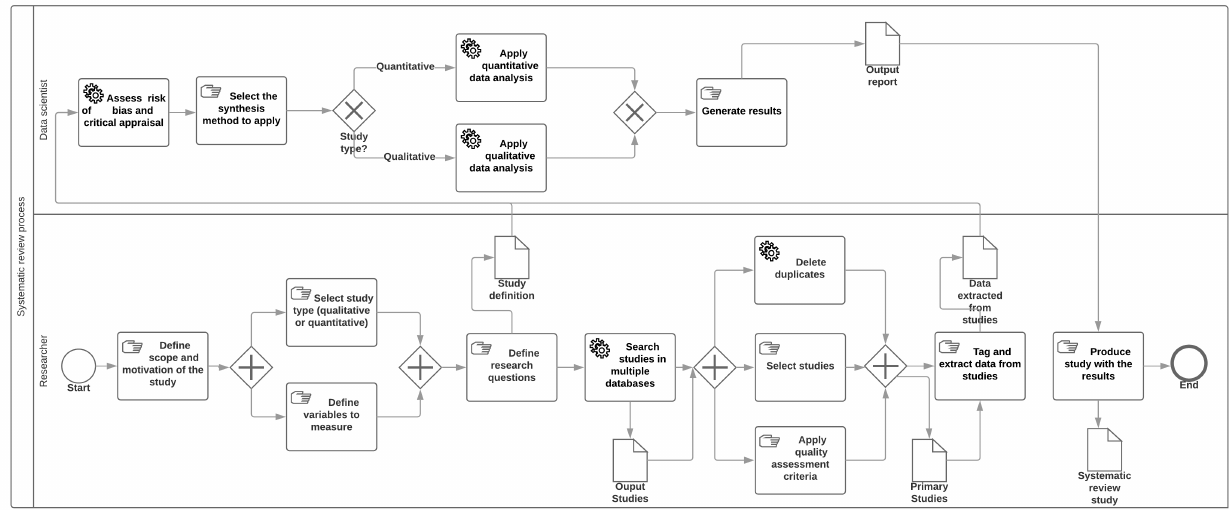
Figure 1. Systematic review process